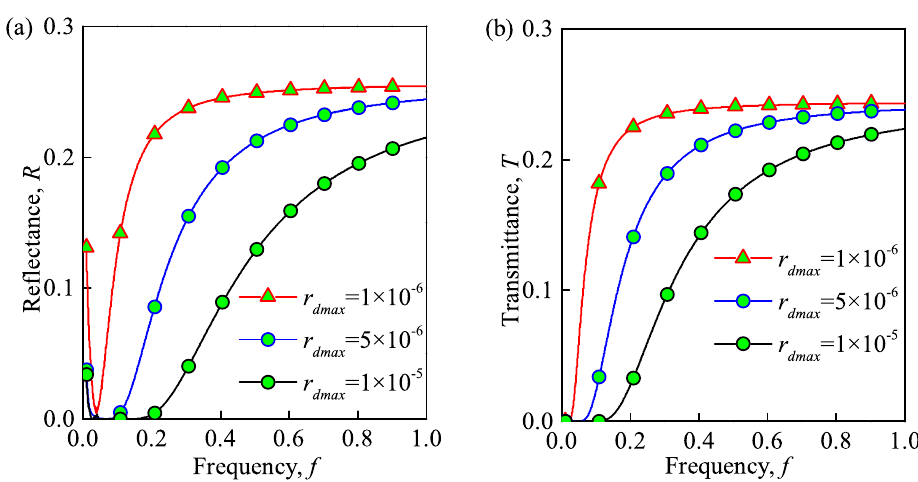
Figure 7. Reflectance ( a ) and transmittance versus ( b ) wave frequency under different radii of dust particles. ( N 0 = 1 × 10 19 m − 3 , N d = 1 × 10 14 m − 3 , v ef f = 0.1 THz).